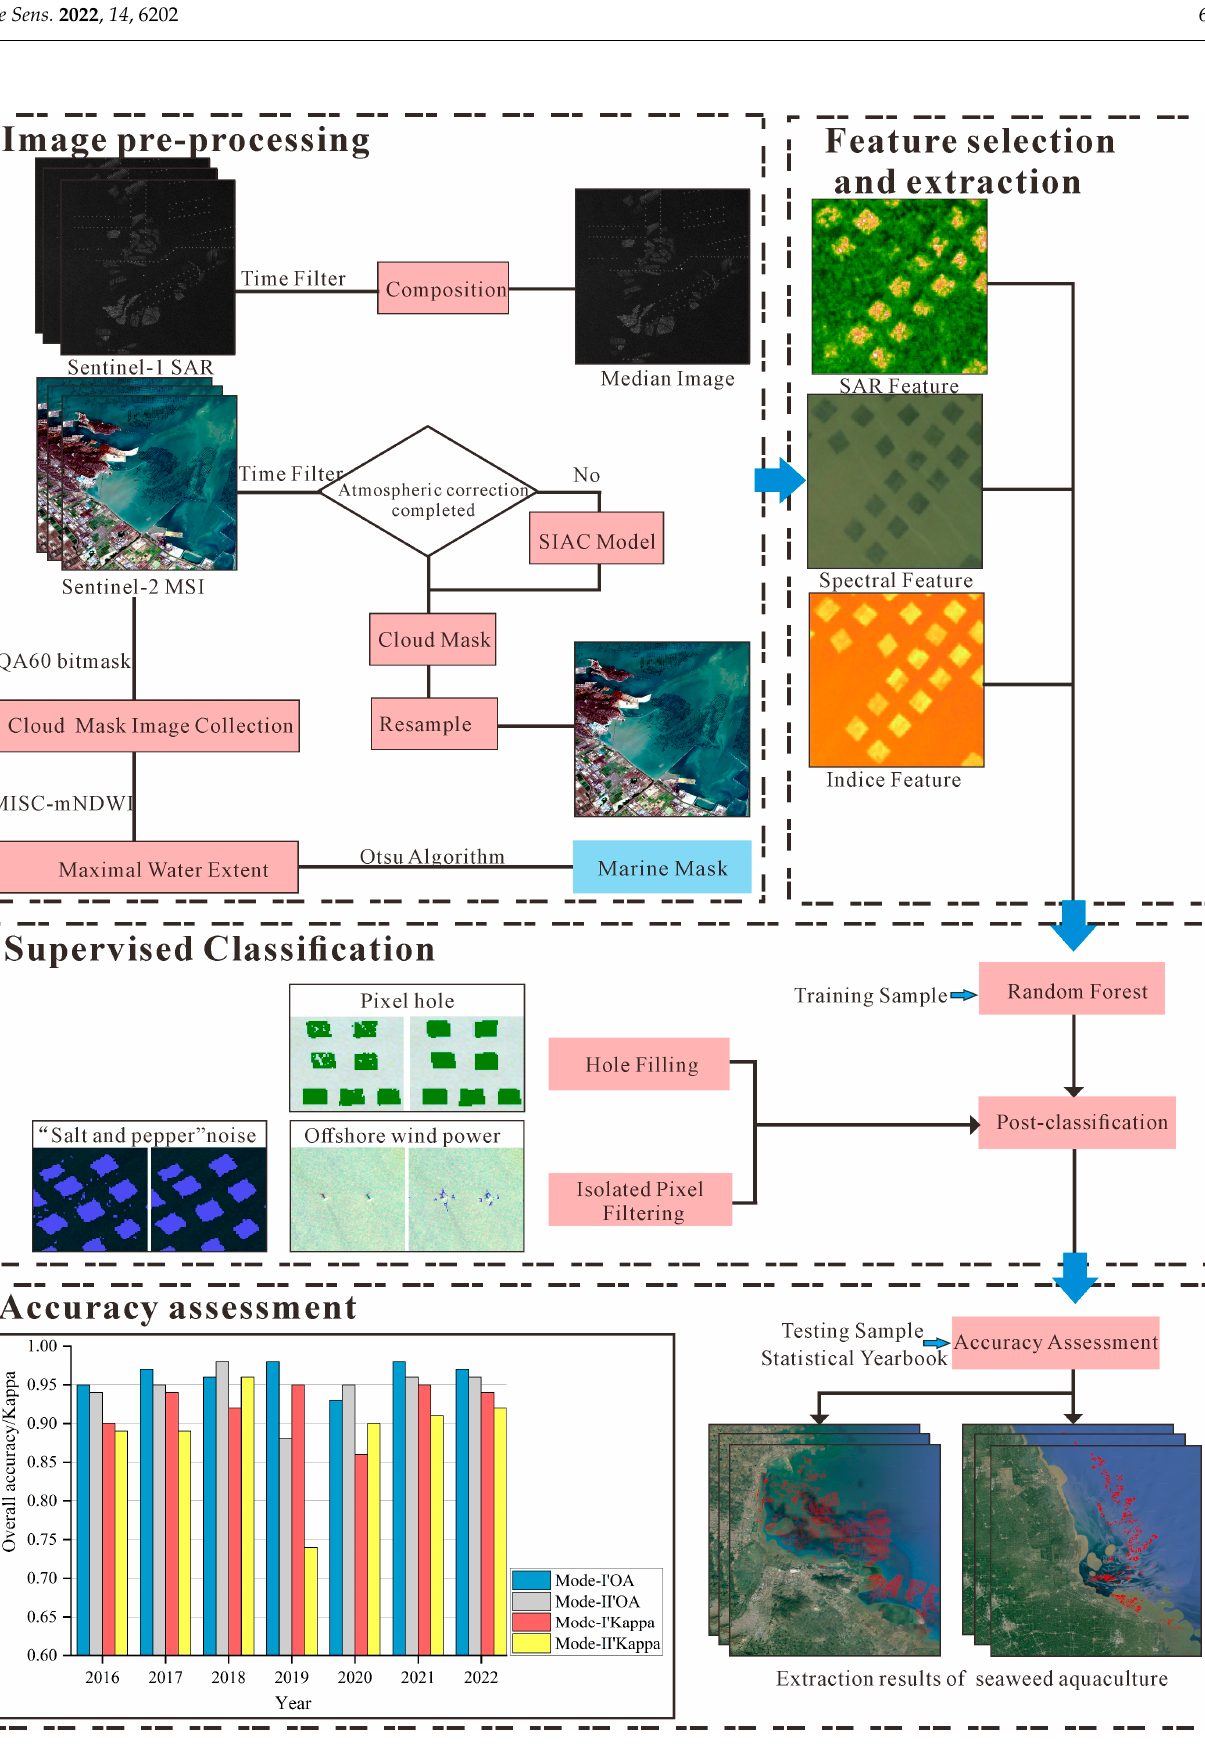
Figure 3. Process flow for extracting seaweed aquaculture area.